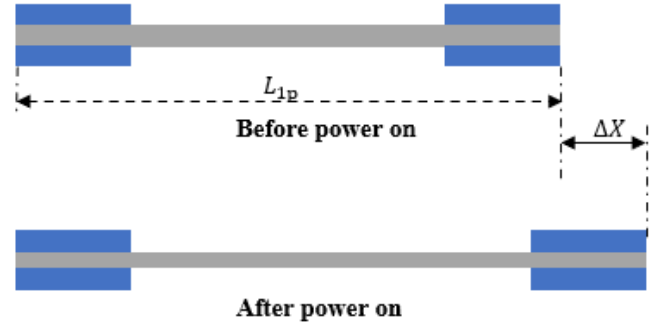
Figure 2. Simplified model of the actuator and its parameters.